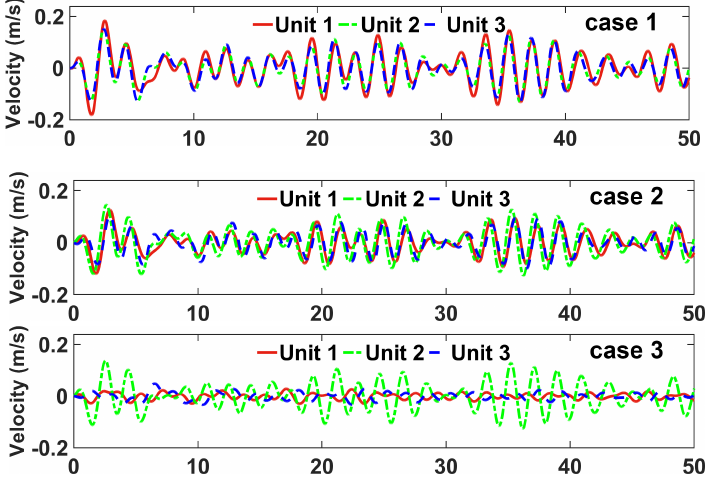
Figure 4. Interaction of radiation wave velocities received by each unit.